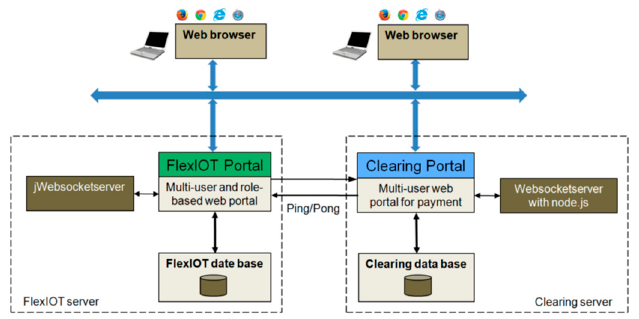
Figure 13. Basic structure of the interaction between the FlexIOT portal and the clearing system.